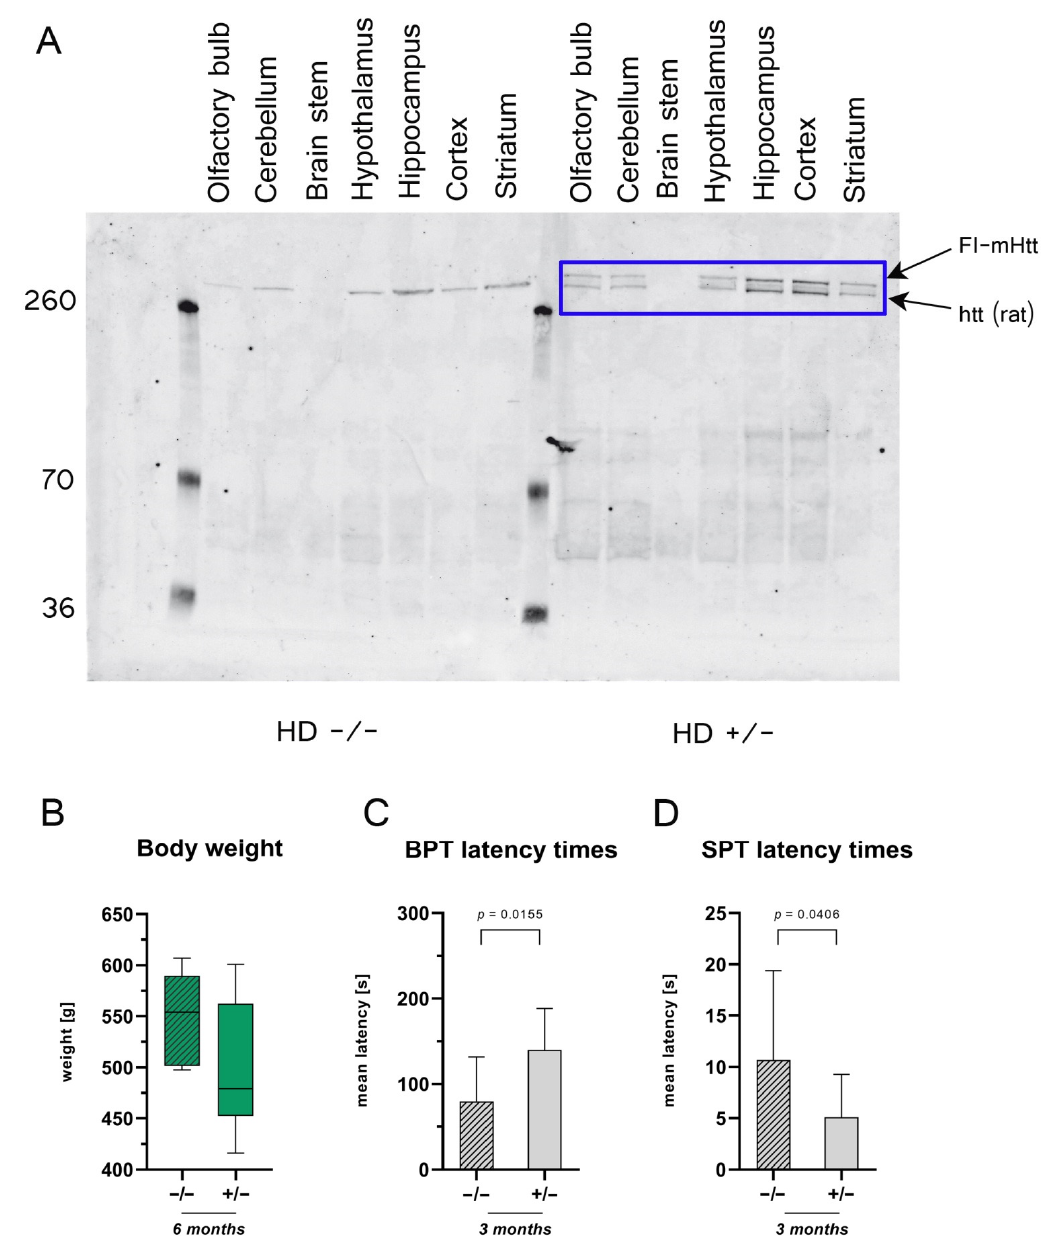
Figure 1. Validation of the bacterial artificial chromosome Huntington disease (BACHD) rat model. ( A ) Western blot analysis of mHTT expression in various brain regions in transgenic line 22 (TG22) using antibody MAB2166. mHTT was present in the olfactory bulb, cerebellum, hypothalamus, hippocampus, cortex and striatum but lacking in the brain stem (blue rectangle). The mHTT expression correlated with the expression of endogenous htt. ( B ) Body weights of 6-month-old (6 M) rats; n = 6, respectively. ( C ) Mean latency times for 3-months-old rats in the buried pellet test (BPT), n = 10, respectively. Latency times for finding a buried pellet were averaged over 5 days. ( D ) Mean latency times in the surface pellet test (SPT) for 3-months-old rats, n = 10, respectively. The significance of differences between groups was tested with an unpaired t -test (( B ) F value = 2.335, degree of freedom = 5; ( C ) F value = 1.146, degree of freedom = 9) or with a Mann–Whitney test ( D ). Data are presented as means ± SD and statistical significance was set at p <